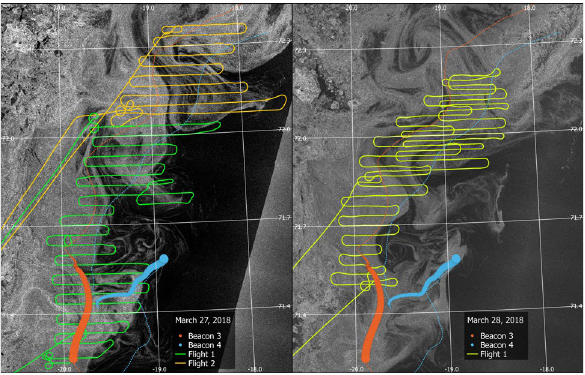
Figure 3. Aerial photo survey tracks and trajectories from two GPS beacons, overlaid on images of ice conditions on the consecutive photo survey days (March 27–28). Dashed lines represent the complete beacon trajectories, while the dots represent paths over the two survey days (dot size increases over time). Both images are from the Synthetic Aperture Radar (SAR) product, the one from March 27 was taken by the Sentinel S1A satellite at 08:11:58 UTC (March 27), and the one from March 28 by the Sentinel S1B satellite at 13:40:39 UTC, with a ground resolution of ~40 x 120 meters (X x Y). Note: Graticule labels in the figure are in decimal degrees, while coordinates in the text are in degrees and